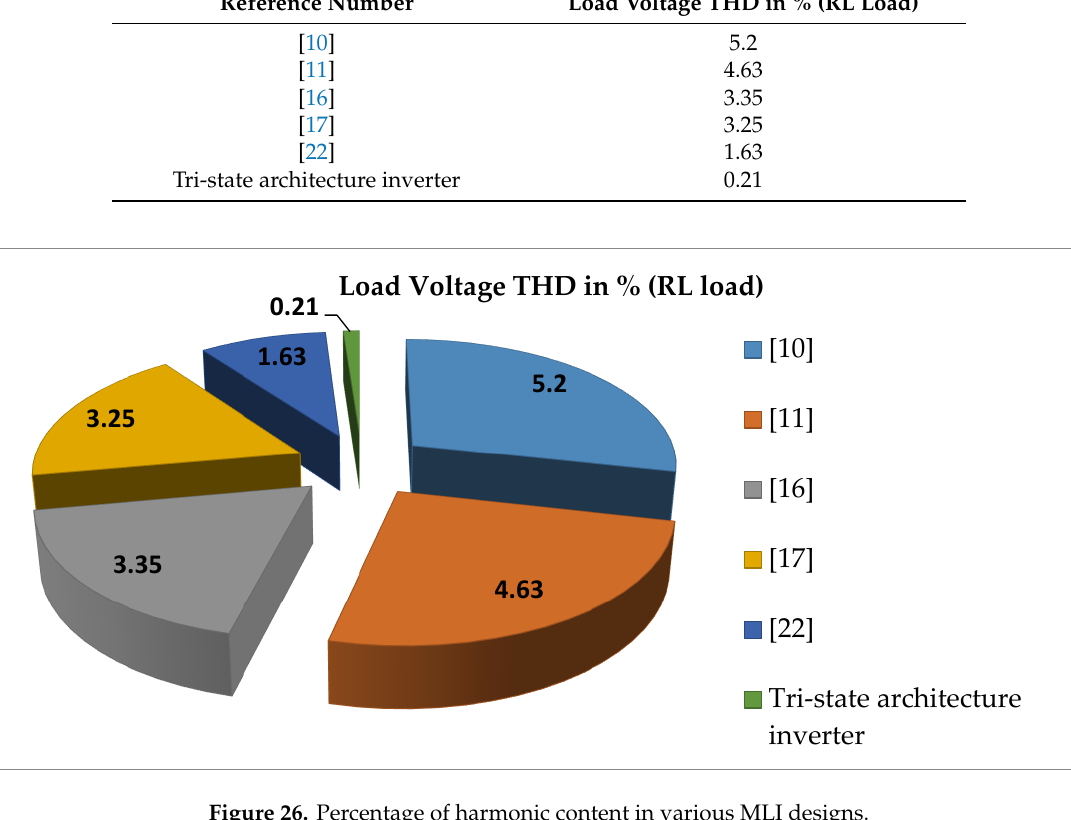
Figure 26. Percentage of harmonic content in various MLI designs.